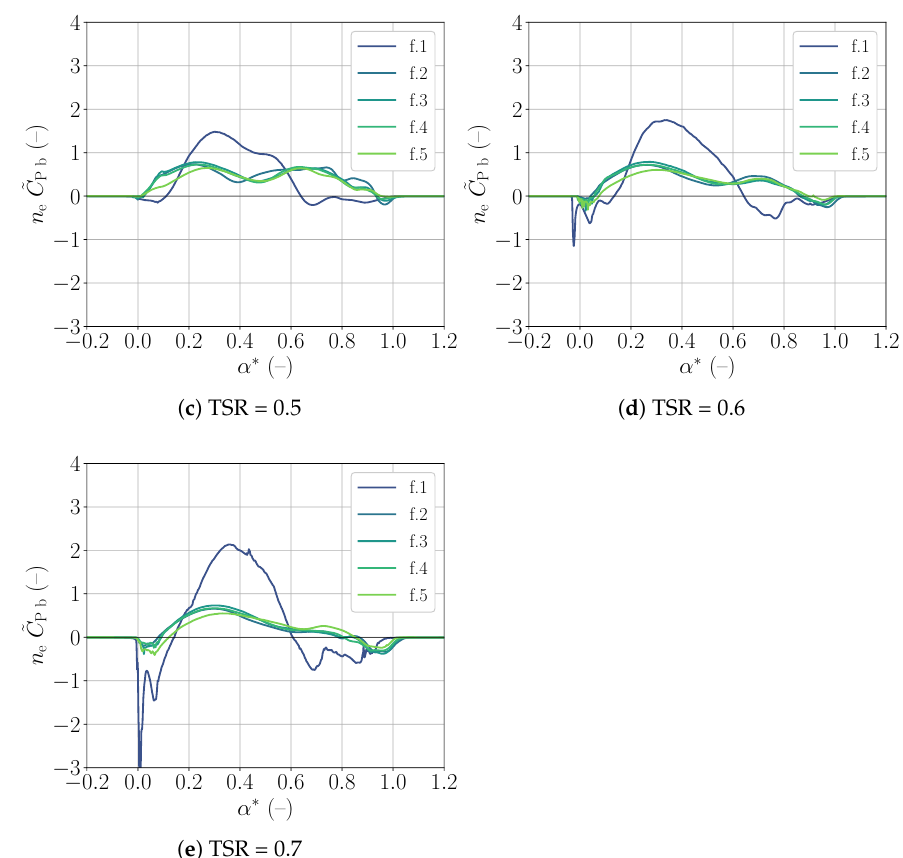
Figure 11. Nondimensional blade power curves ( n e ˜ C P,b ) as a function of nondimensional stroke angle ( α ∗ ) for the five Pareto-optimal wheels, plotted in separate diagrams for different tip-speed ratios. The part of the curves below the zero-line corresponds to energy transferred from the wheel to the water, which should obviously be